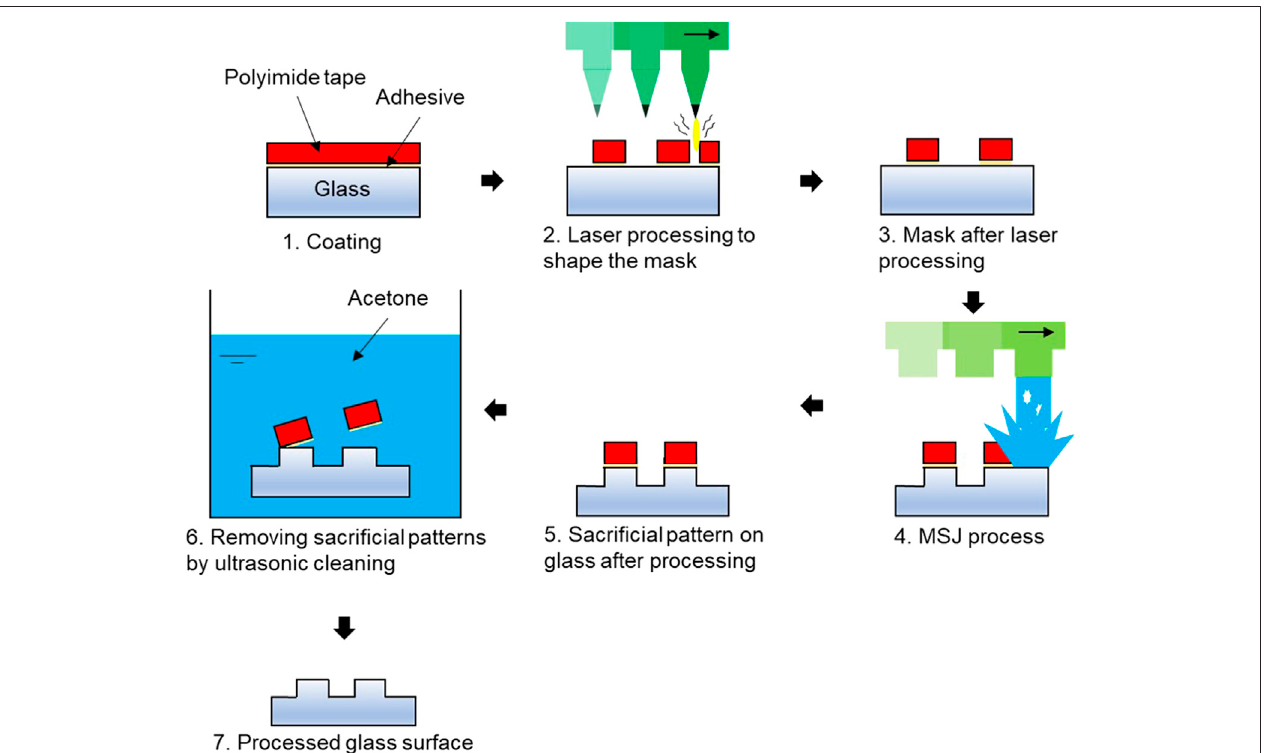
FIGURE 1 | Method for the formation convex structures on glass surfaces.